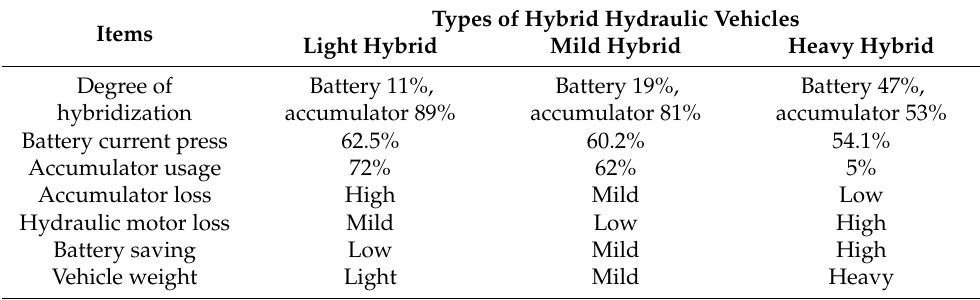
Table 5. Summary characteristics of evaluations of accumulator size in hydraulic–electric hybrid vehicles.